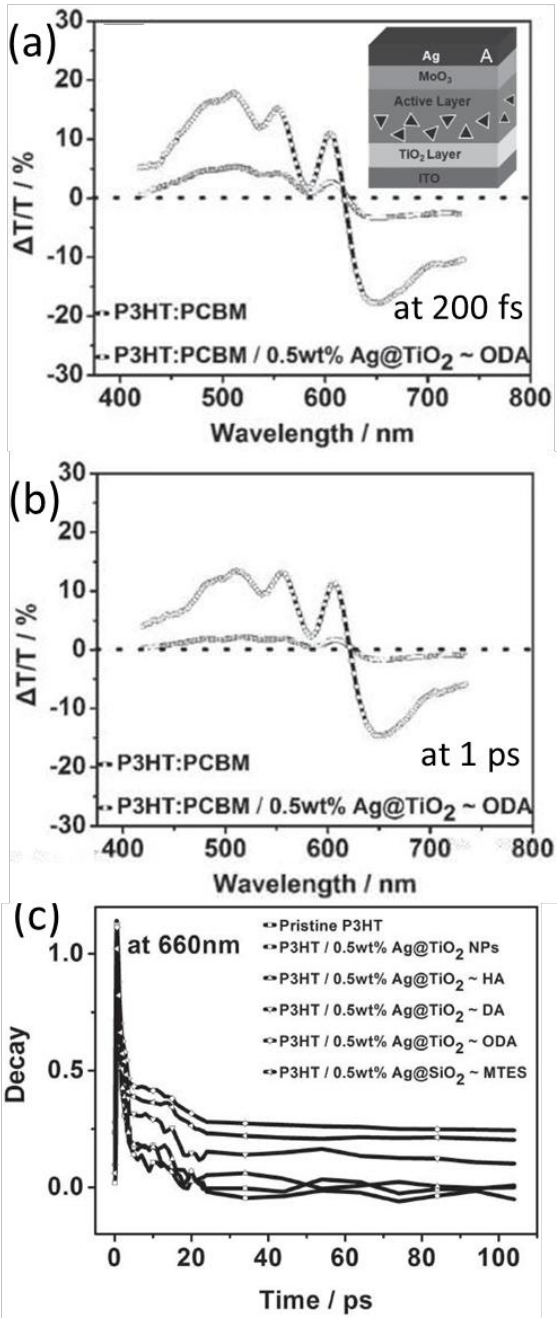
Figure 17. Relative differential transmissions of P3HT:PCBM films with delay times of ( a ) 200 fs and ( b ) 1 ps after excitation with 400 nm laser beam. ( c ) Transient decays of P3HT film, P3HT blended with Ag NPs, and P3HT blended with Ag@oxides nanoprisms. PIA decay monitored at 660 nm [93]. Reprinted with permission from Ref. [93].